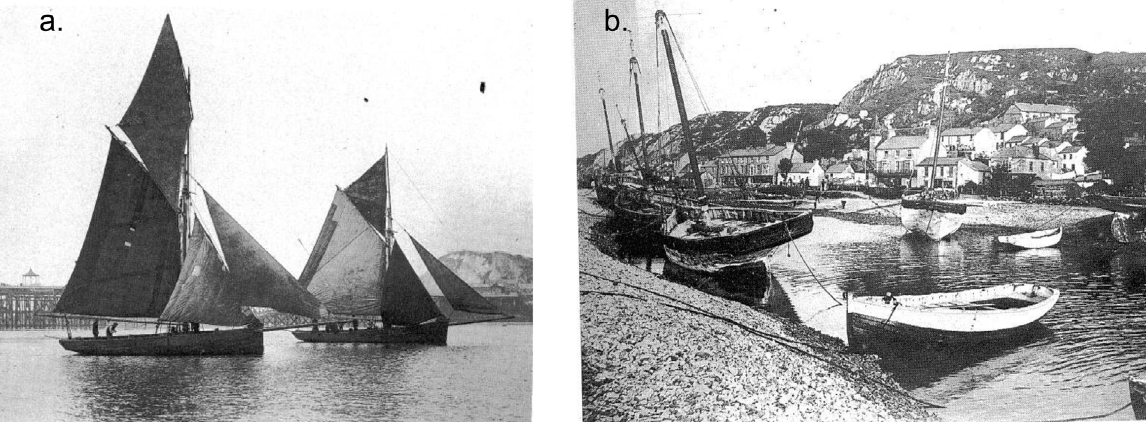
Fig. 5. (a) Photo of Mumbles oyster skiffs ‘ Snake ’ and ‘ Hawk ’ taken by R. J. H. Lloyd. (b) Photo of oyster skiffs in Oystermouth Harbour, Mumbles (both images sourced from Jenkins,